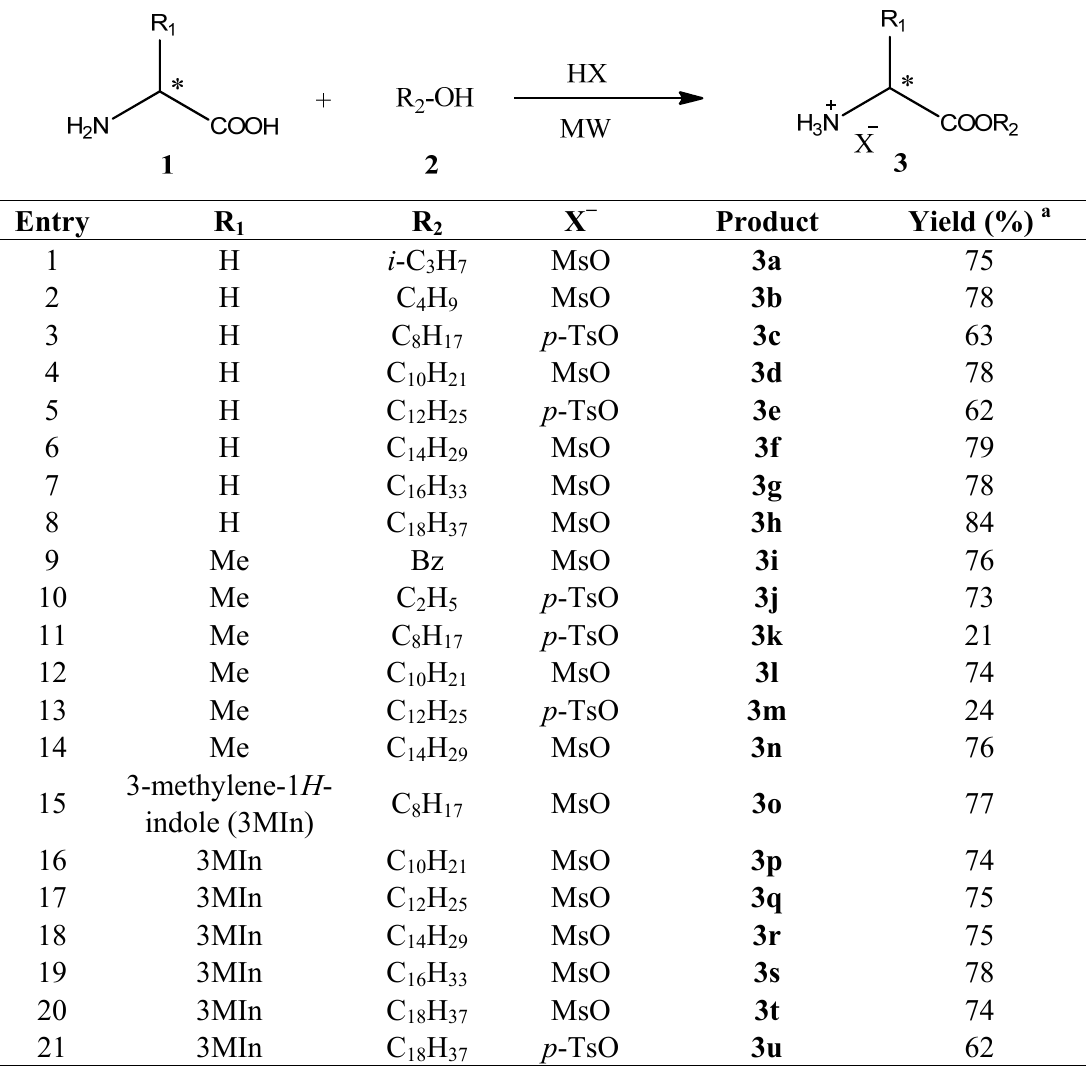
Table 1. Parallel synthesis of ionic-esterified amino acids under microwave